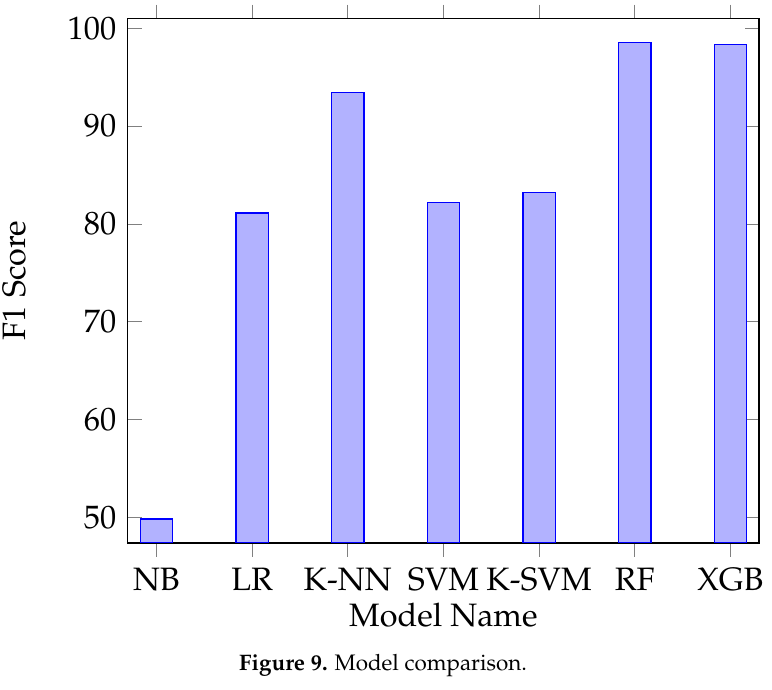
Figure 9. Model comparison. Table 5. Initially selected features.